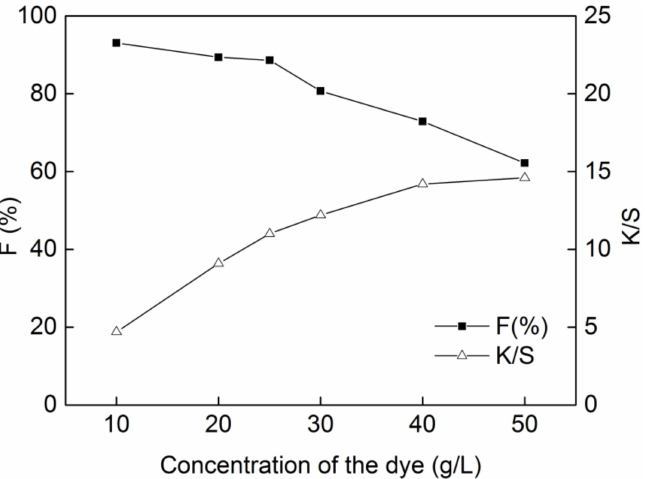
Figure 4. Effect of dye concentration on dyeing properties of DB 1 (sodium carbonate of 12 g/L, dipping time of 3 min and steaming time of 15 min with “one-dip–one-nip”